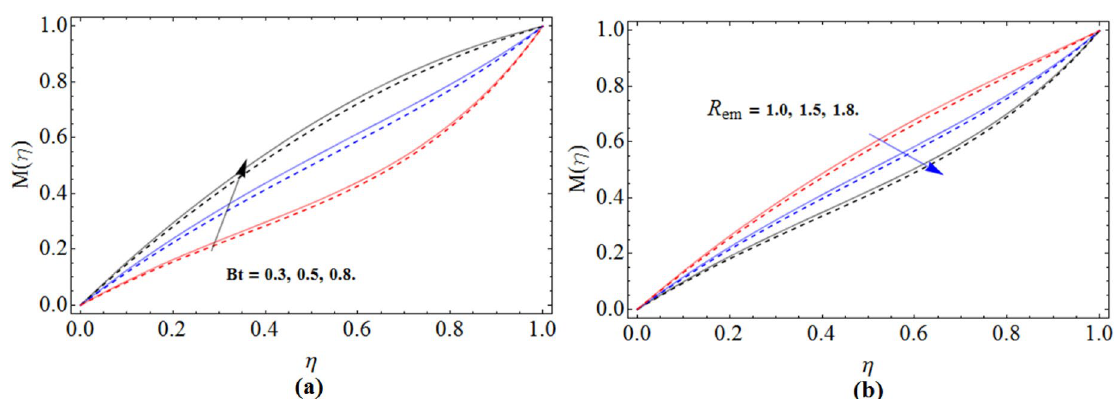
Figure 8. Bt and R em impact on magnetic strength profile M (η) for S 2 , when S 1 = 0.0. dashed lines for (cid:31) = 0.5 and lines for (cid:31) = −